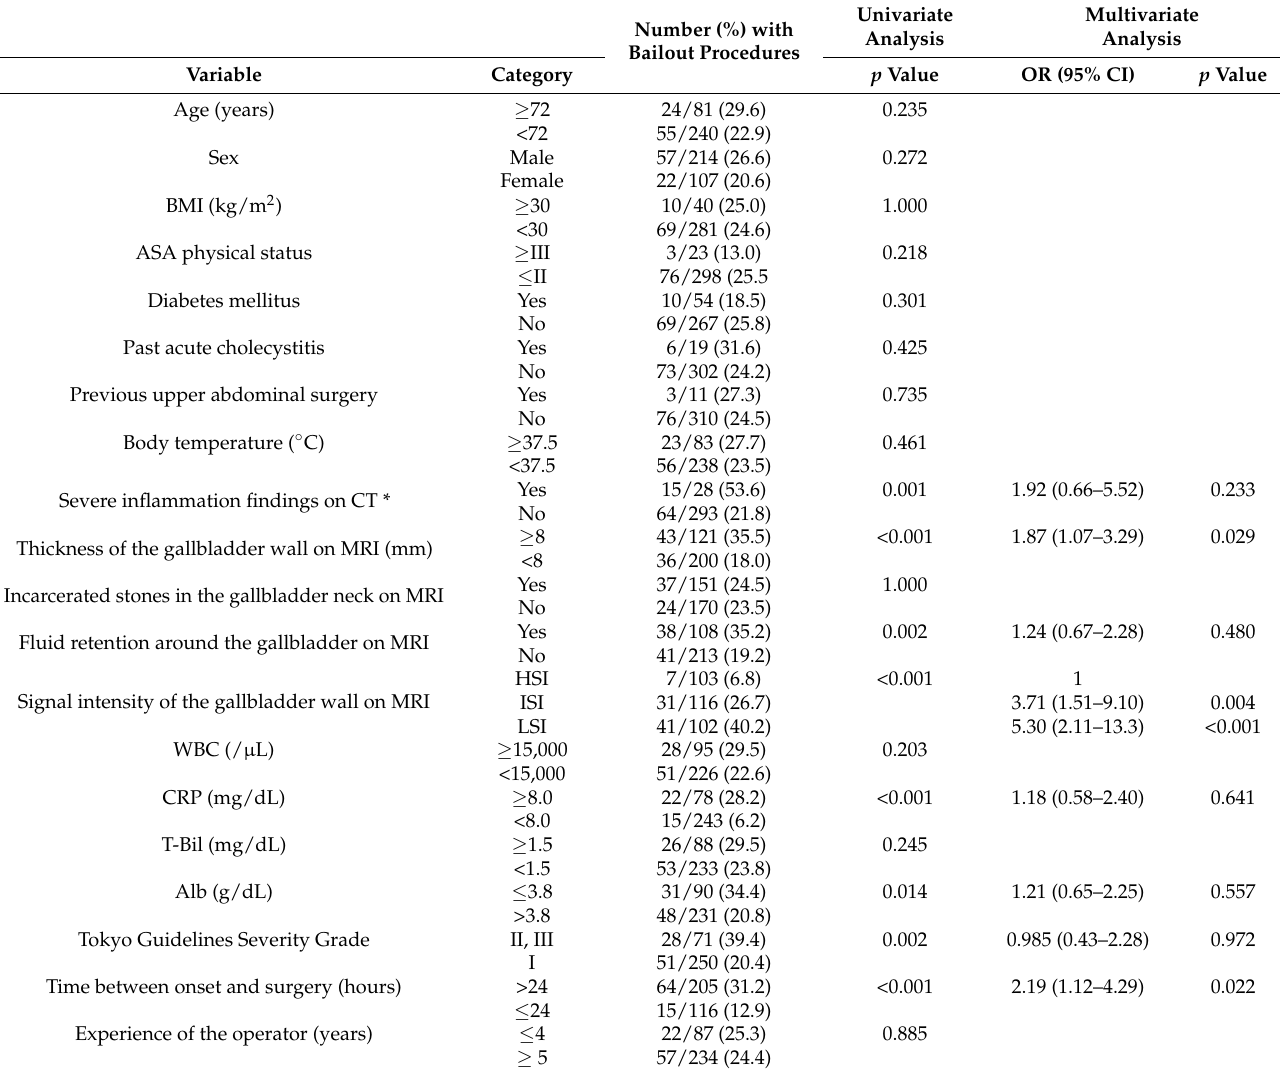
Table 3. Univariate and multivariate analyses of risk factors for bailout procedures.